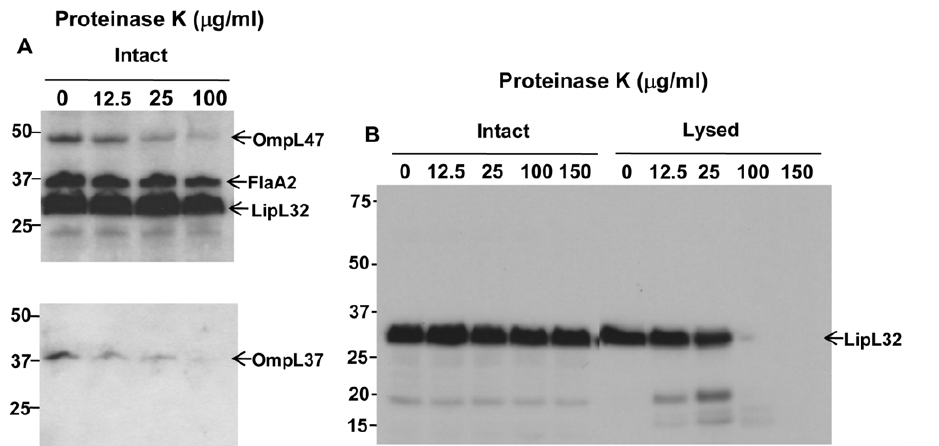
Figure 1. Surface localization of L.interrogans serovar Copenhageni strain Fiocruz L1-130 proteins by protease K treatment. (A) Whole intact spirochetes were incubated with different concentrations of Proteinase K. 1 6 10 8 of leptospires per lane were separated by gel electrophoresis (Bis-Tris 4–12% NuPage gel, Novex), transferred to a PVDF membrane, and probed with polyclonal rabbit antisera against: LipL32, OmpL47, OmpL37, FlaA2 and LipL31. (B) Whole intact leptospires and cells lysed with 50 mM Tris-HCL (pH 8.0), 100 mM NaCl, 2 mM EDTA, 0.2% SDS and boiling for 5 min were treated as above and probed with rabbit serum recognizing LipL32. The data is representation of four experiments performed separately. The identities of individual proteins are indicated on the right, and the positions of molecular mass standard (in kilodaltons) are indicated on the left.